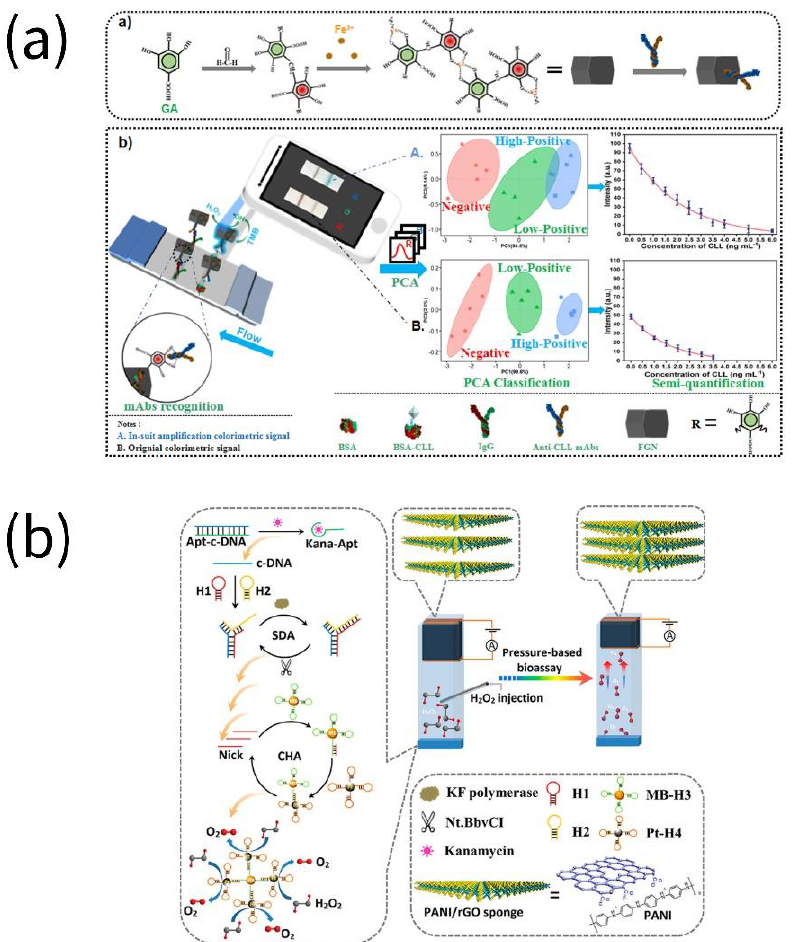
Figure 4. Assays for the detection of veterinary drugs in food by nanozymes. ( a ) Clenbuterol was detected using Fe-GA nanozymes (reprinted with permission from [55], Copyright 2022, Elsevier). ( b ) Kanamycin was detected using polyaniline-nanowire-functionalized reduced-graphene-oxide (PANI/rGO) framework (reprinted with permission from [57], Copyright 2018, American Chemical Society).